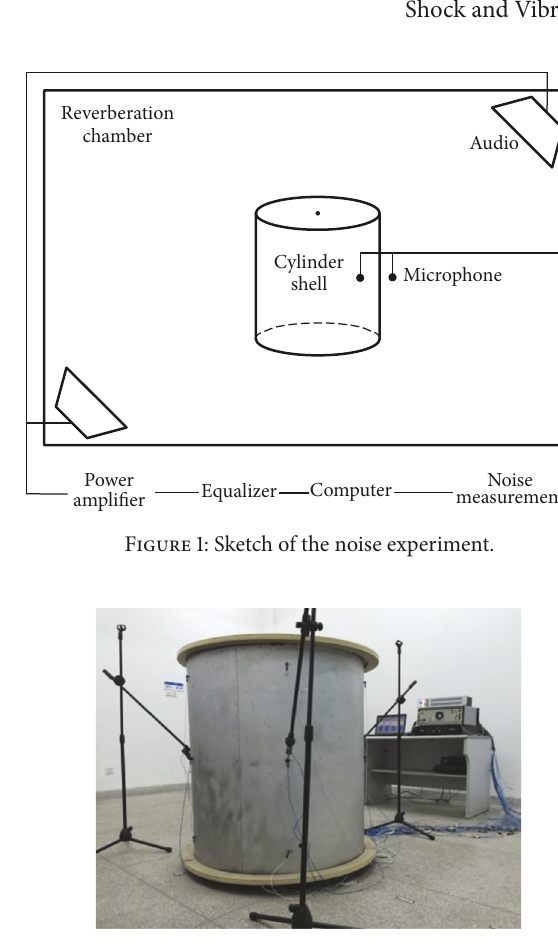
Figure 2: Sketch of external sound field